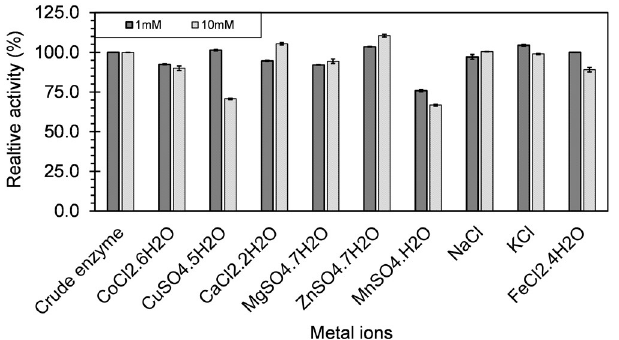
Figure 9. The effect of metal ion on the xylanase activity of Geobacillus sp. strain DUSELR13. The activity of the crude xylanase is taken as 100% (30.6 U/mL) and effect of the metal ions on the xylanase activity is expressed as the percentage of the initial activity. The values are mean of triplicate experiments and the error bars represent ± SD of the means with n = 3.